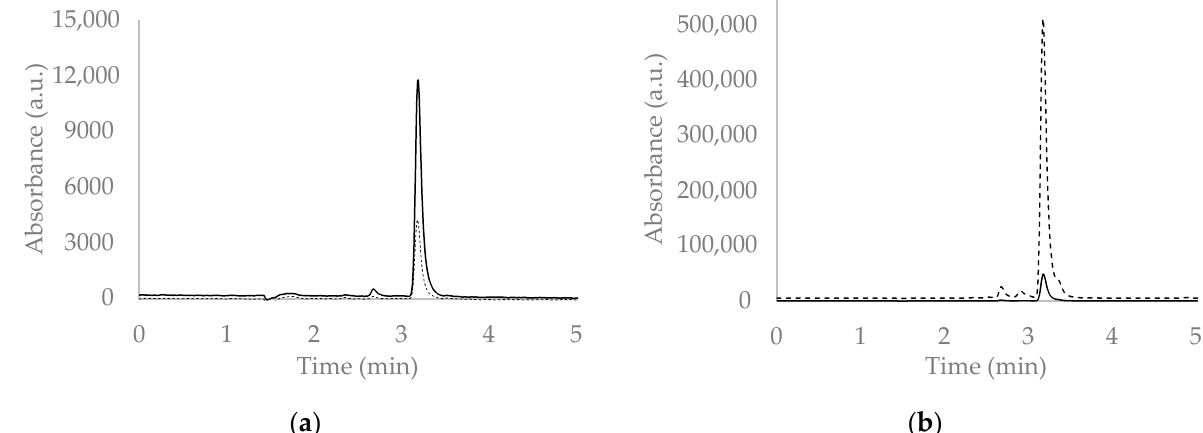
Figure 1. Chromatograms of ( a ) 0.0 µ M of AuCl 4 − and ( b ) 10.0 µ M of AuCl 4 − in presence (plain line) or absence (dashed line) of rat liver.